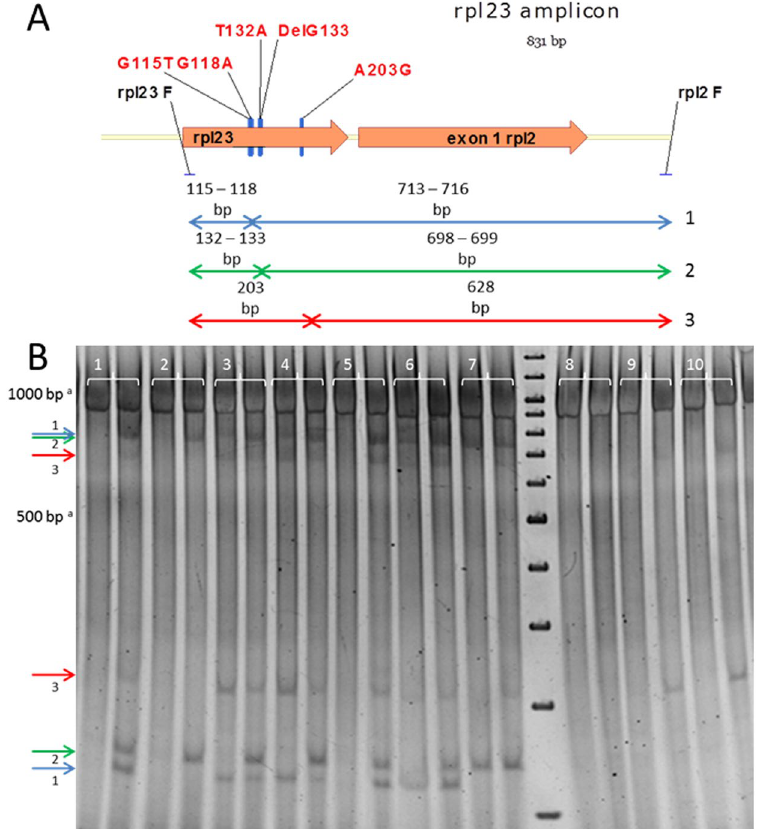
Figure 2. The rpl23 amplicon. ( A ) Polymorphisms detected in the rpl23 gene. ( B ) CJE digestions of rpl23 amplicons corresponding to 10 cpm seedlings on a nondenaturing 3% polyacrylamide gel. The first and second lanes of each sample correspond to the digestion of the sample alone and mixed with wild-type DNA in a 1:1 ratio, respectively. The samples show different digestion patterns because they carry several combinations of polymorphisms: seedlings 1, 3, 4, 5 and 6 carry G115T, G118A, T132A, DelG133 and A203G; seedling 2 carries T132A and DelG133; seedling 7 carries T132A, DelG133 and A203G; seedling 8 does not carry any polymorphism and seedlings 9 and 10 carry A203G. a The samples run slower than the molecular weight marker probably due to the components of the CJE digestion